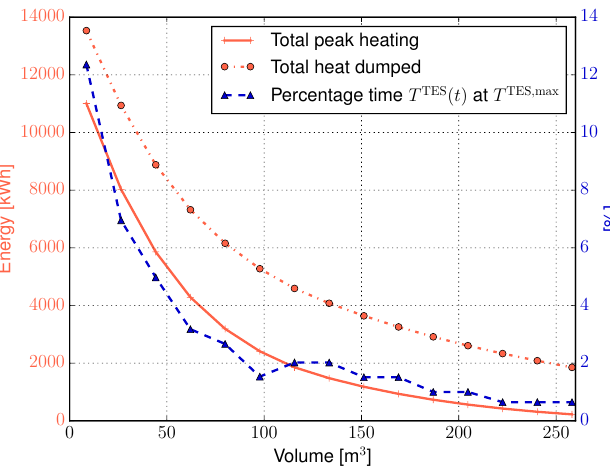
Figure 10. Total peak energy use, total heat dumped (rejected) and total time the storage temperature T TES ( t ) is at its upper bound T TES , max during the 24-h time horizon as a function of TES volume V TES